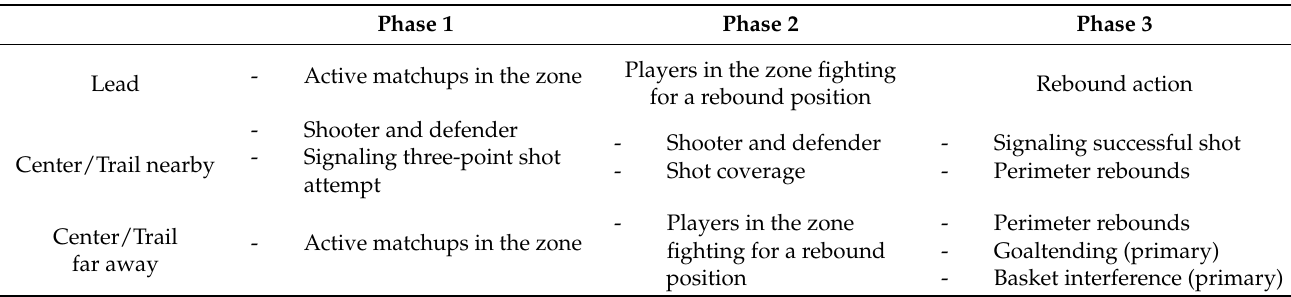
Table 1. Responsibilities of the three referees—divided into “Lead”, “Center/Trail nearby” and “Center/Trail far away”— during the three phases of a three-point shot in